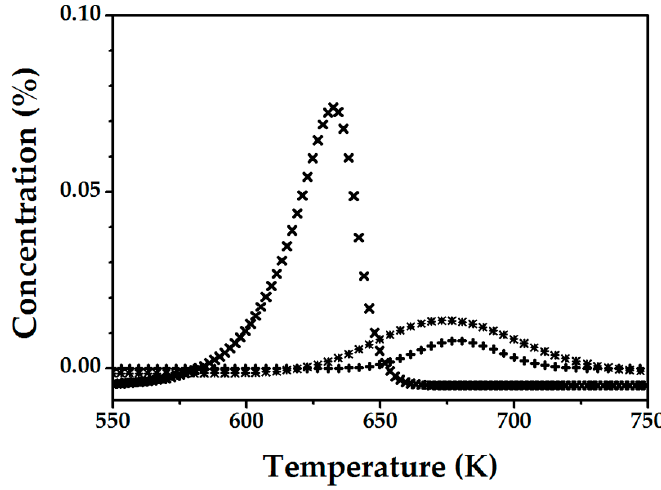
Figure 2. O 2 -( (cid:54) ), NO-( (cid:58) ) and N 2 O-TPD ( (cid:81) ) profiles for FeZSM-5 2300Fe activated in He at 973 K for Figure 2. O 2 -(  ), NO-(  ) and N 2 O-TPD (  ) profiles for FeZSM-5 2300Fe activated in He at 973 K for 30 30 min, after contact with N 2 O at 523 K for 5 min. min, after contact with N 2 O at 523 K for 5 min. Table 5. N 2 O adsorbed after chemisorption at 523 K (for 5 min) on FeZSM-5 2300Fe . Final Isothermal Hold Time (min)